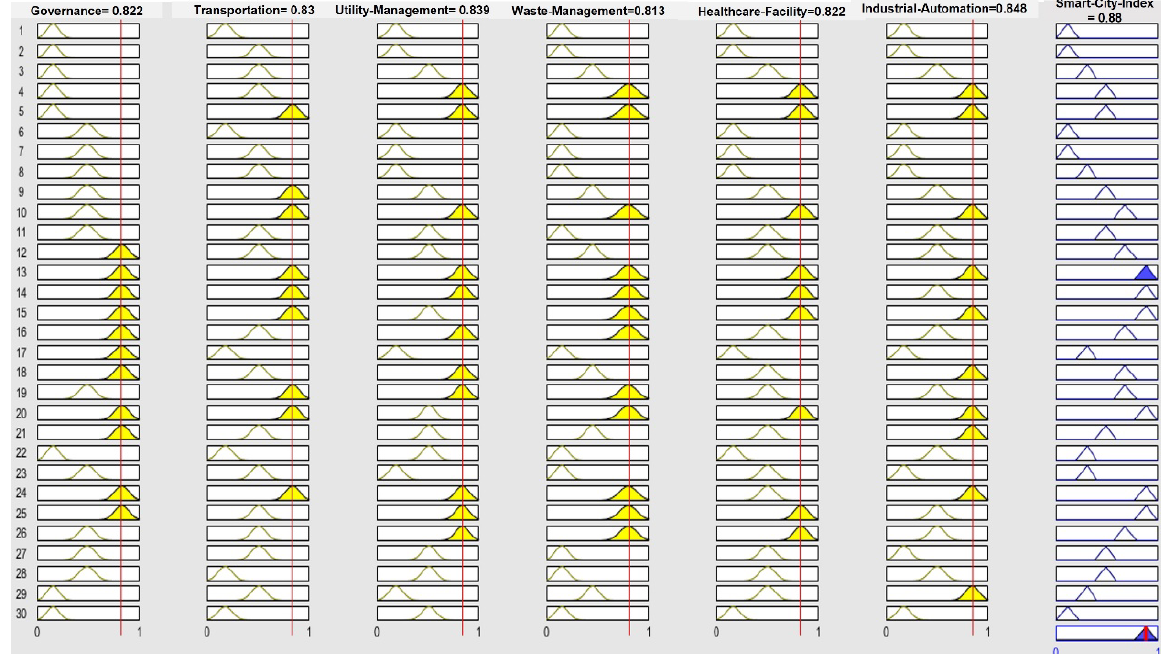
Figure 6. Fuzzy rule viewer.